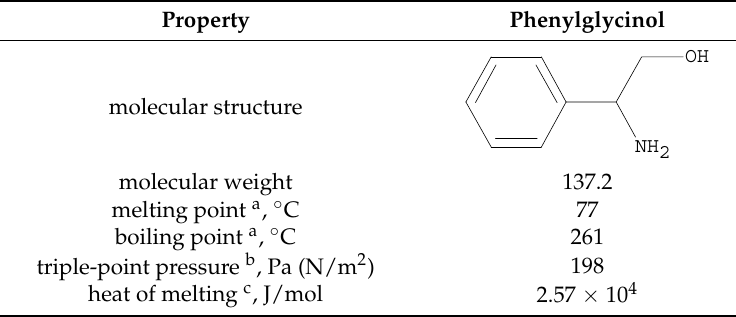
Figure 2. P(T), X B (T) and Y B (T) based on the thermodynamic calculations for the three-phase transformation.